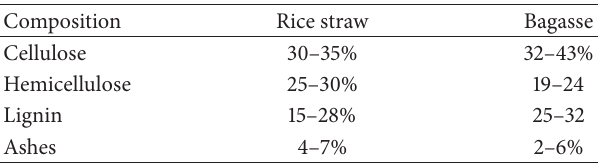
Table 1: Composition of rice straw and sugarcane bagasse (Sak- daronnarong and Jonglertjunya (2012)) [11]. Composition Rice straw Bagasse Cellulose 30–35% 32–43% Hemicellulose 25–30% 19–24 Lignin 15–28% 25–32 Ashes 4–7%